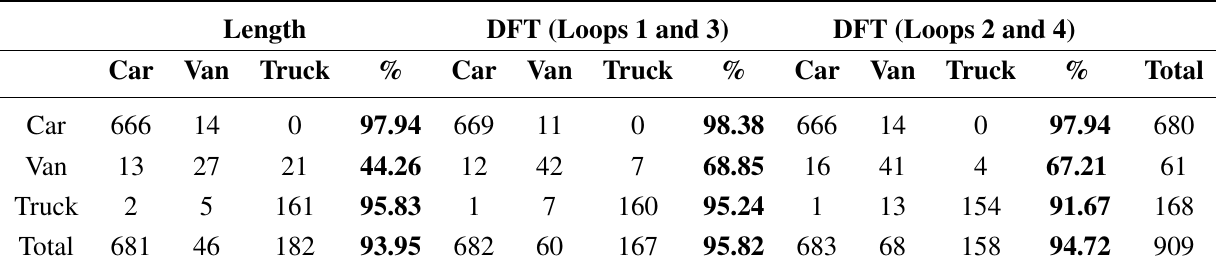
Table 1. Confusion matrices for AC-523